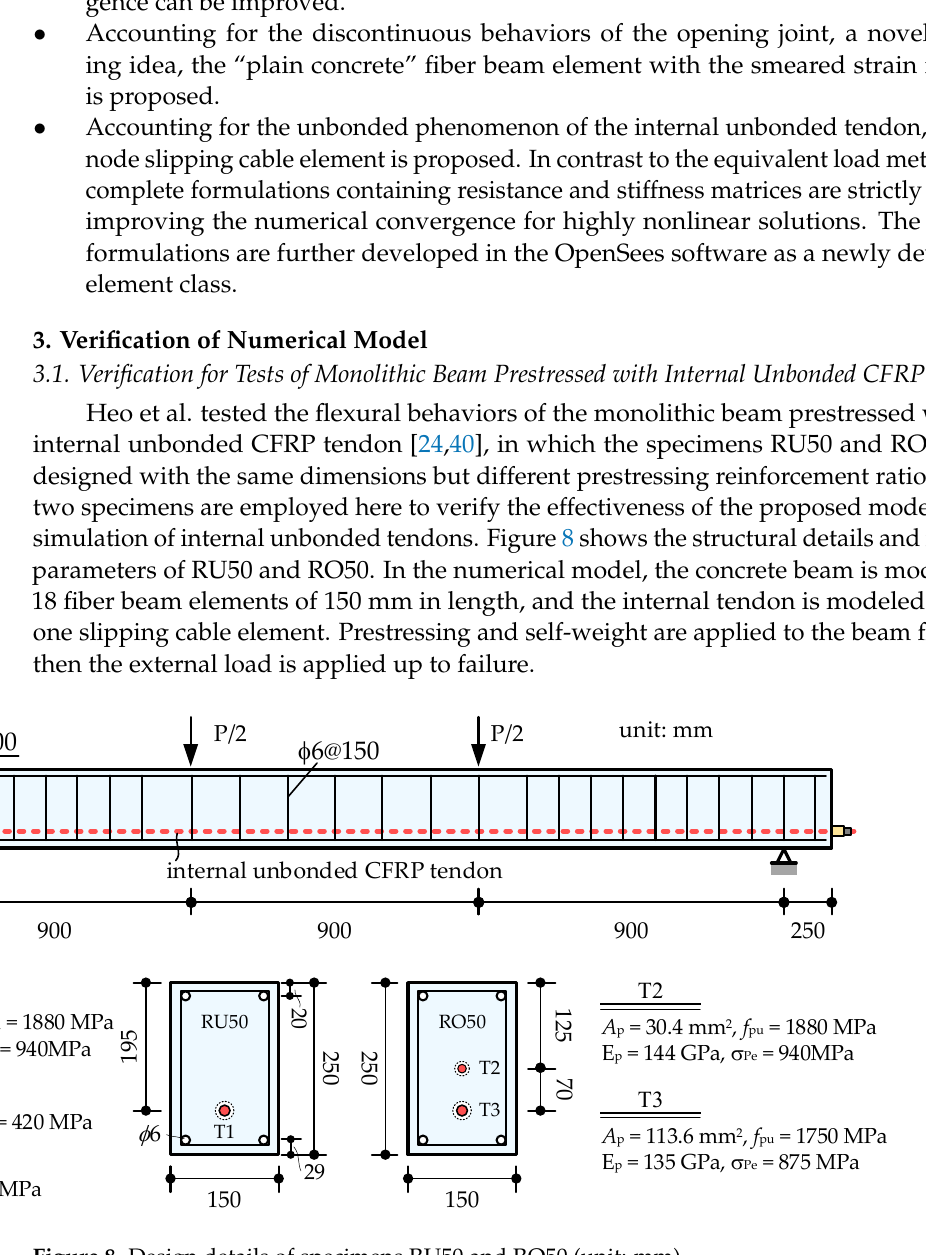
Figure 8. Design details of specimens RU50 and RO50 (unit: mm).